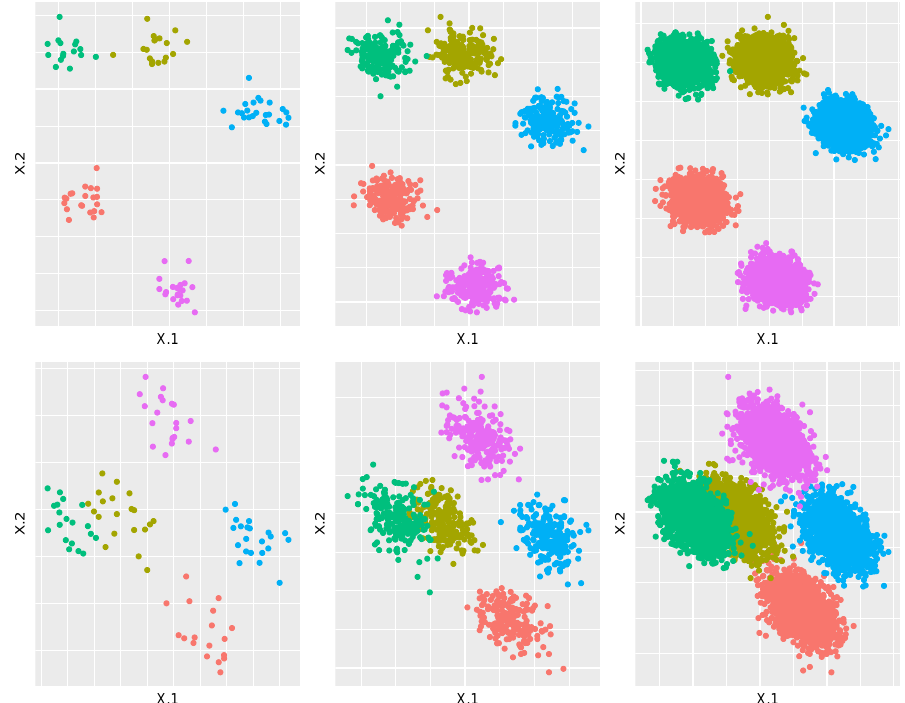
Figure 2. Examples of artificial datasets with two dimensions and five components with a variable number of observations and an overlap level. The upper three graphs had a = 0.001 and the lower three graphs had a = 0.125. From left to right, the number of observations were respectively n = 100, n = 1000, and n = 10,000. Table 1 summarizes the input parameters. Using all the combinations of input parameters, 18 different parameters of GMMs were simulated. Sampling of the datasets from each simulated GMM was done with n = 100, n = 1000, and n = 10,000 observations, which resulted in 54 different datasets. Table 1. Input parameters used for simulating different Gaussian mixture models. Parameter Values Dimension ( d ) 3, 5, 10 Number of components ( c ) 5, 10, 15 Overlap level ( a ) 0.001,